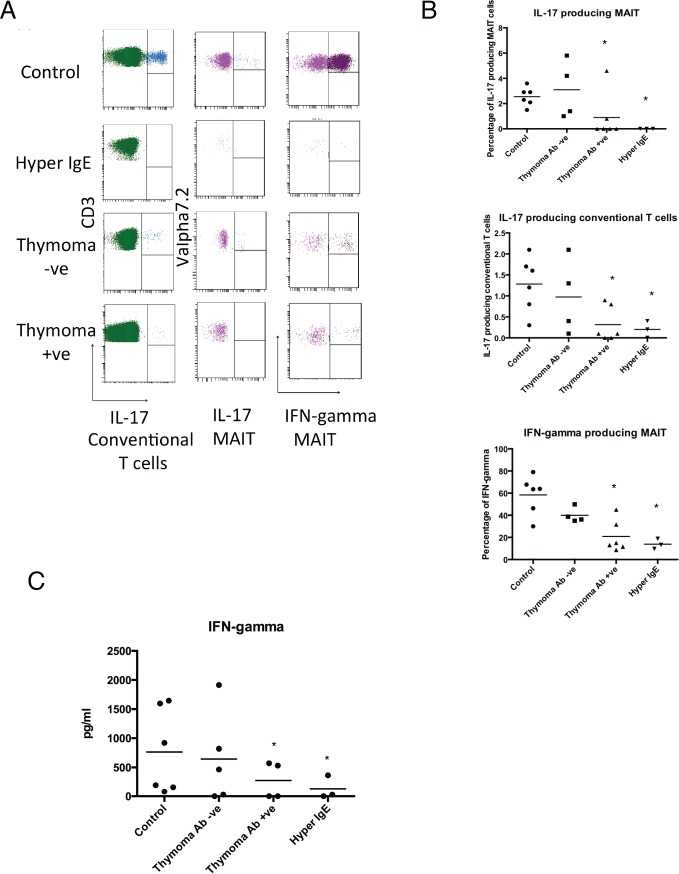
(A) Intracellular cytokine production of Il-17 and IFN-γ by MAIT and conventional T cells in representative control and patient groups. (B) Mean percentage of IL-17 and IFN-γ T cells (MAIT and conventional) in controls and patient groups. The percentage of IL-17 conventional and MAIT cells was significantly reduced in the thymoma positive, HIES patients (*P<0.03). MAIT IFN-γ production was lower in HIES and thymoma positive patients. (C) IFN-γ assessment of enriched MAIT cells across the clinical cohorts following IL-12/18 stimulation.